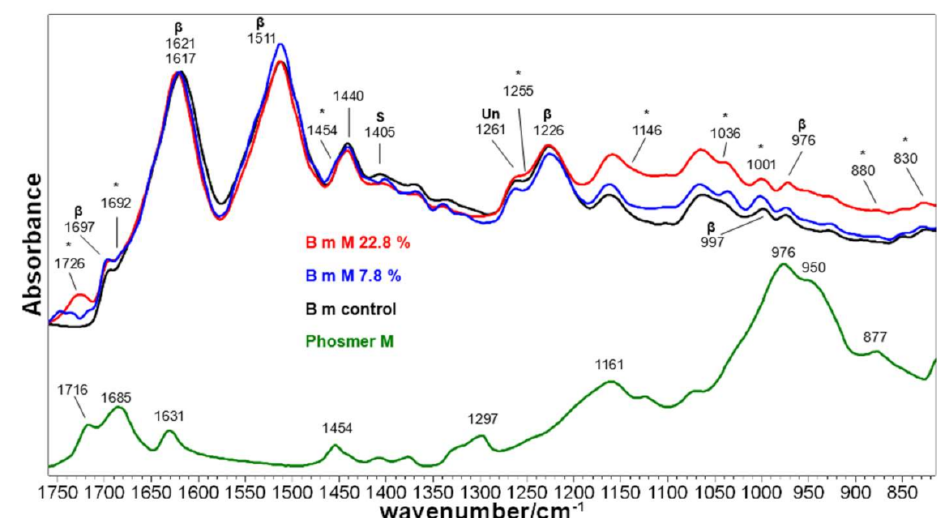
Figure 6. IR spectra of B. mori silk fibroin fabrics before (control) and after grafting with phosmer M (weight gains 7.8% and 22.8%). The spectra are normalized to the Amide I band at 1617 cm − 1 . The spectrum of phosmer M is reported for comparison. Asterisks (*) indicate the main spectral features ascribable to phosmer (see Supplementary Material for assignments). The main bands assignable to β -sheet conformation ( β ), unordered (Un) structures and serine (S) are